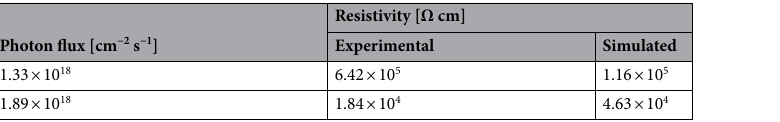
Table 3. Resistivity measurements and simulations of illuminated 4H-SiC material for two photon flux